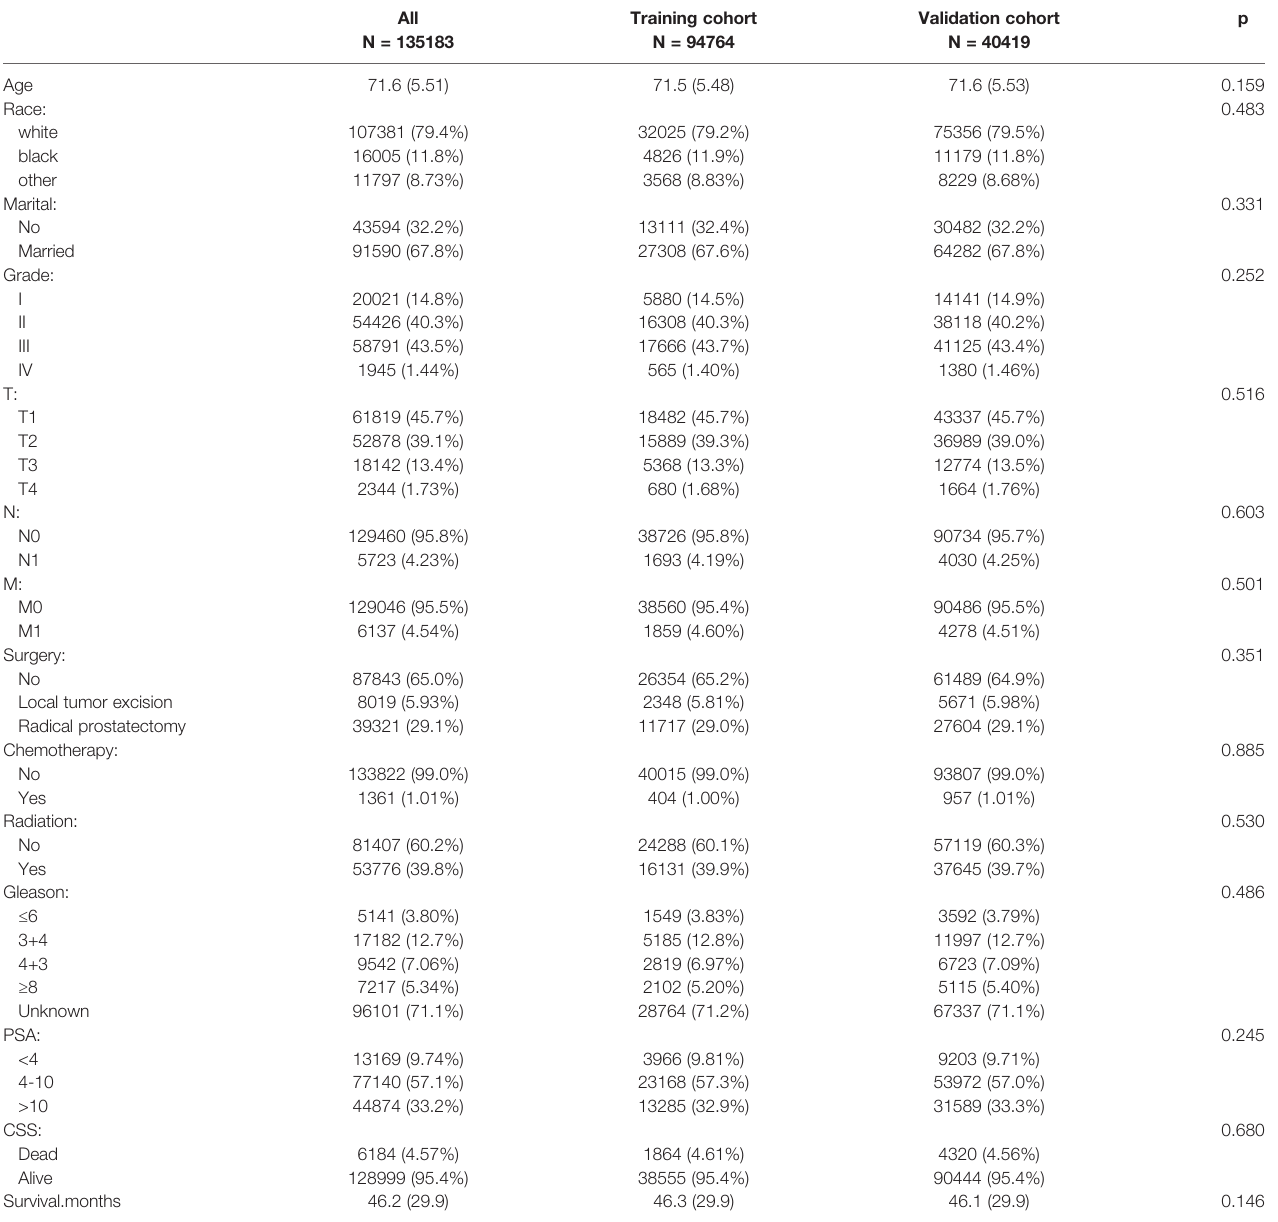
TABLE 1 | Clinicopathological characteristics of elderly patients with